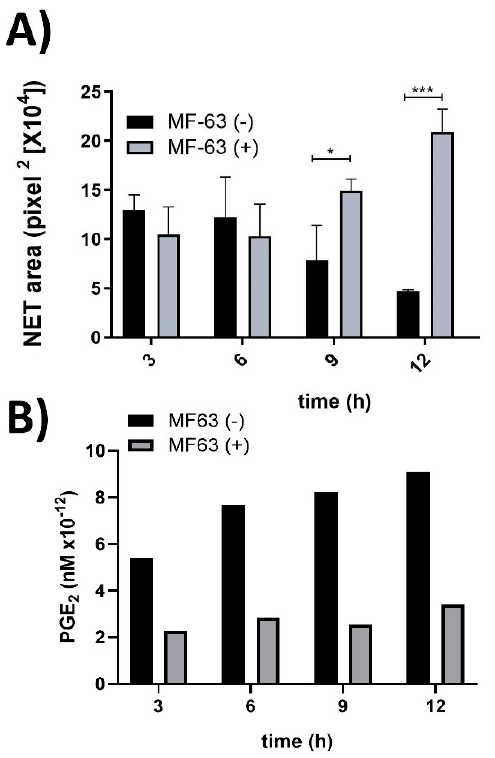
Figure 2. PGE 2 secreted from hAM-MSC decreased NET release. NET from ionomycin (1.25 µM)- stimulated neutrophils were inhibited in the presence of hAM-MSC-CM without MF-63 (10 µM) treatment at 9 and 12 h, while this inhibition was prevented with hAM-MSC-CM obtained after MF-63 treatment. The results are expressed as the mean of 3 independent assays performed in triplicate. Bars represent the mean ± SE, * p < 0.5; *** p < 0.001. CM (conditioned medium) was collected at the indicated time points from hAM-MSC incubated with MF63 (gray bars) or without MF-63 (black bars) ( A ). Levels of PGE 2 analyzed in hAM-MSC-CM with and without MF-63 treatment. hAM-MSC were cultured in the presence (white bars) and absence (filled bars) of MF-63 for the indicated times. The PGE 2 concentration was measured by ELISA ( B ).